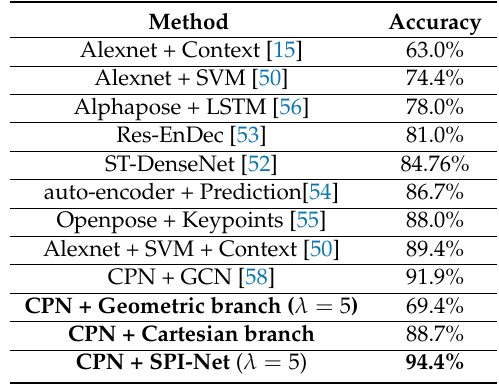
Table 3. Classification accuracies for pedestrian intention prediction for the C/NC task in JAAD. CPN [14], Alphapose [82] and Openpose [83] stand for the use of human pose estimation algorithms used by the skeleton-based features method. We have also included the results reported in [15,50], where CNN features are based on a non-fine-tuned AlexNet [51] and Context refers to features of the environment, not of the pedestrian itself.